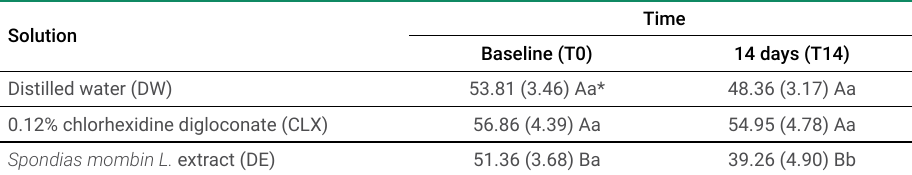
Spondias mombin L. extract